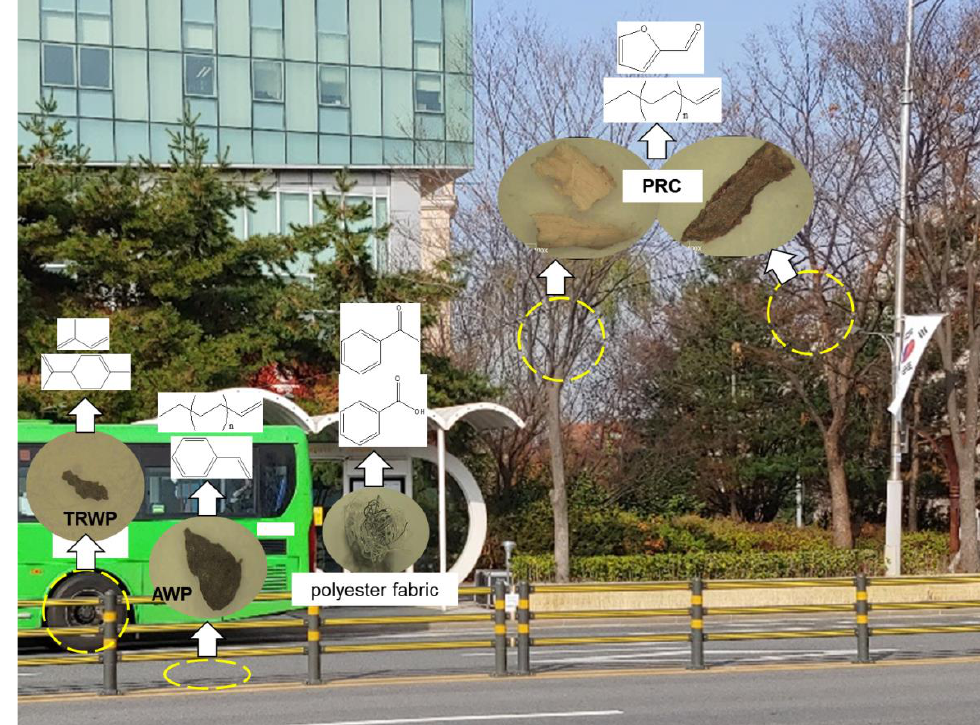
Figure 7. PM sources produced near the bus stop, and the key pyrolysis products for identifying polymeric materials using Py-GC/MS. The yellow circles indicate potential PM sources.